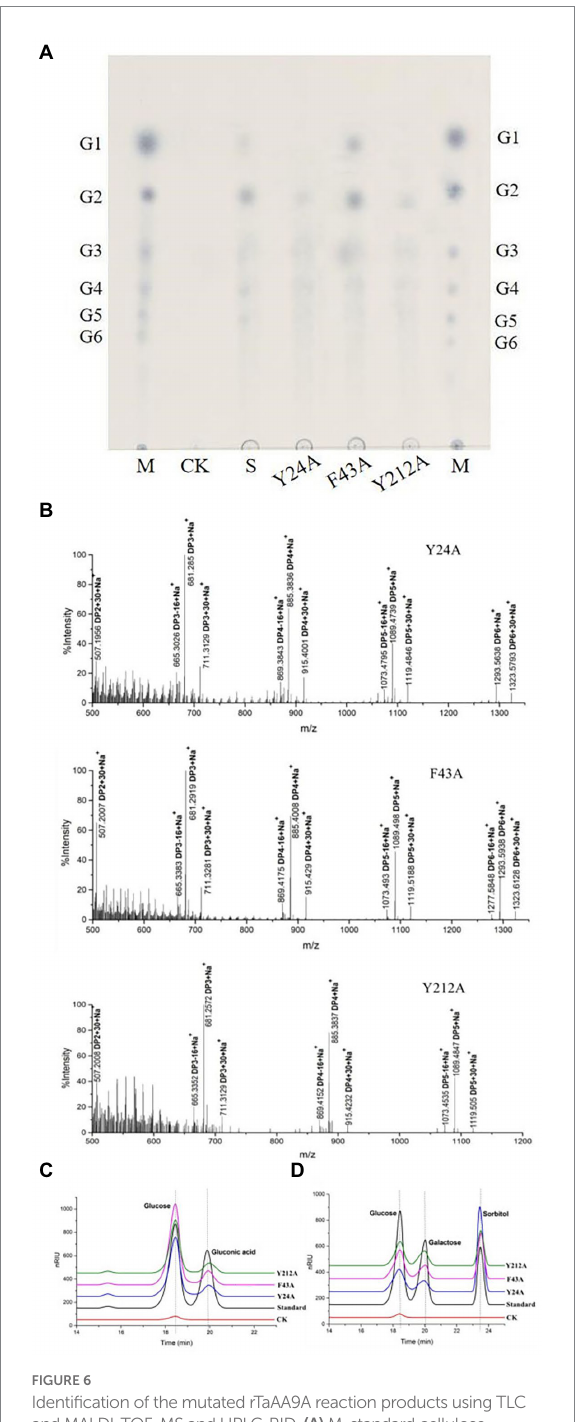
FIGURE 6 Identification of the mutated rTaAA9A reaction products using TLC and MALDI-TOF-MS and HPLC-RID. (A) M, standard cellulose oligosaccharides (G1–G6); S, rTaAA9A reaction products. (B) Identification of the permethylation reaction products of mutated rTaAA9A by MALDI-TOF-MS. The analysis method is the same as Figure 4. (C) Y24A, F43A, and Y212A reaction products were hydrolyzed by TFA. (D) Y24A, F43A, and Y212A reaction products were reduced by NaBH 4 , followed by hydrolysis with TFA. CK, control sample was analyzed as above, except that enzyme was not added. Gluconic acid and galactose were used as